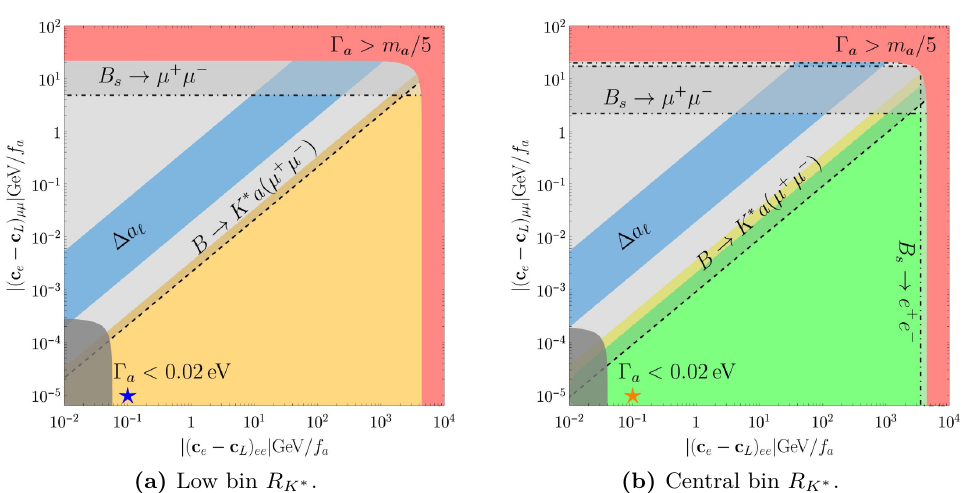
Figure 9. ALP mass within the R K ∗ bin windows. Parameter space | ( c e − c L ) ee | /f a vs. | ( c e − c L ) µµ | /f a that solves the R K ∗ anomaly, in the low energy-bin on the left and in the central energy-bin on the right. In green (yellow) the 1 σ ( 2 σ ) sensitivity. The ALP mass is chosen to be m = 0 . 6 GeV ( m = 1 . 2 GeV) on the left (right) plot together with, respectively, the values a a | ( c d − c Q ) sb | /f a = 3 . 05 × 10 − 10 GeV − 1 and | ( c d − c Q ) sb | /f a = 6 . 46 × 10 − 10 GeV − 1 , chosen to com- ply with the B → K ∗ e + e − bounds. The shaded red region corresponds to the exclusion condition Γ 5 , while the dark grey one to the prompt decay condition. The light grey region delimited a < m a / by an oblique dashed line is excluded by the LHCb search for an exotic resonance decaying to muons. The light grey regions delimited by horizontal and vertical dot-dashed lines are excluded by B + µ − and B + e − data, respectively. The blue band shows the parameter space s → µ s → e compatible with ∆ a once the photon coupling is fixed to comply with bounds on ∆ a µ